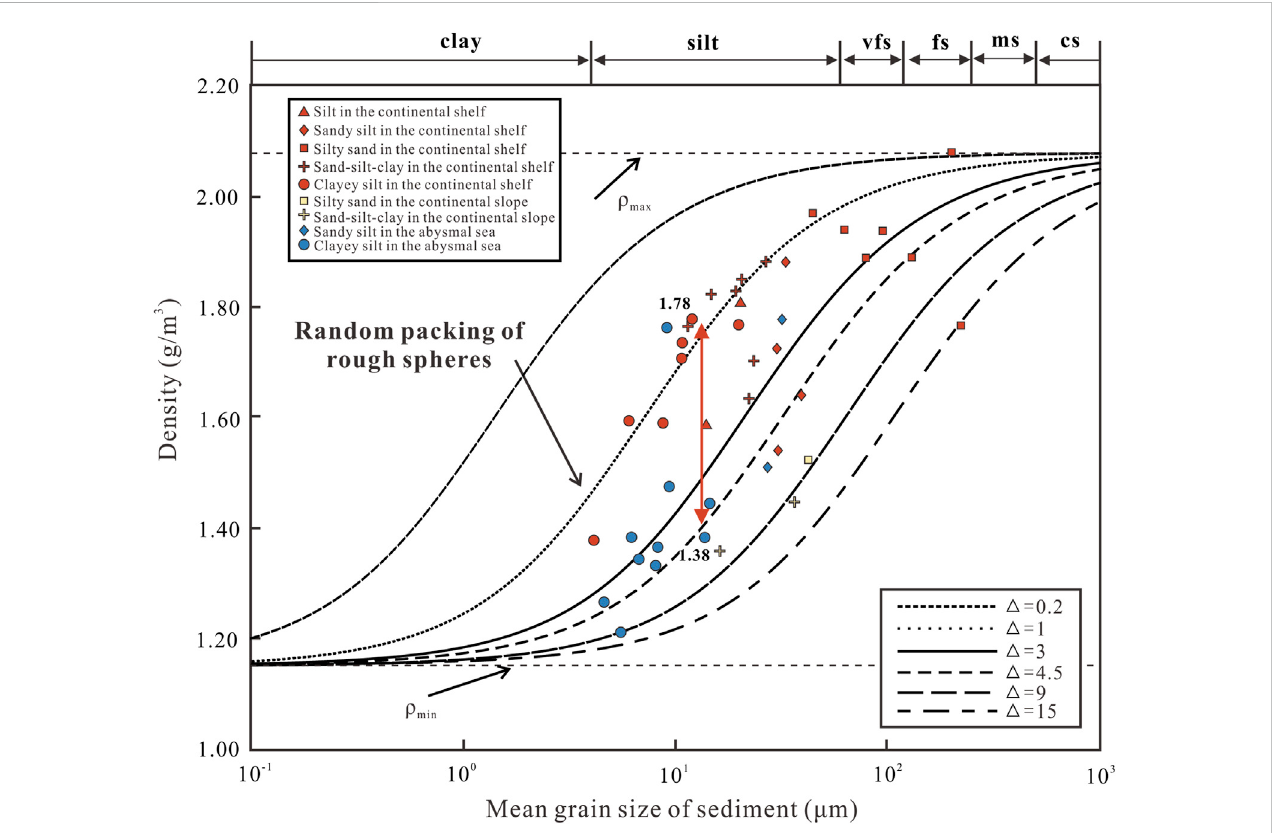
FIGURE 4 Relationship between the mean grain size and density of sea fl oor sediment from the SCS, respectively. The line represents the mean grain size versus porosity and density curve of RMS (root mean square) roughness = 0.2, 1, 3, 4.5, 9, and 15 μ m vfs is very fi ne sand; fs is fi nesand; ms is medium sand; and cs is coarse sand.